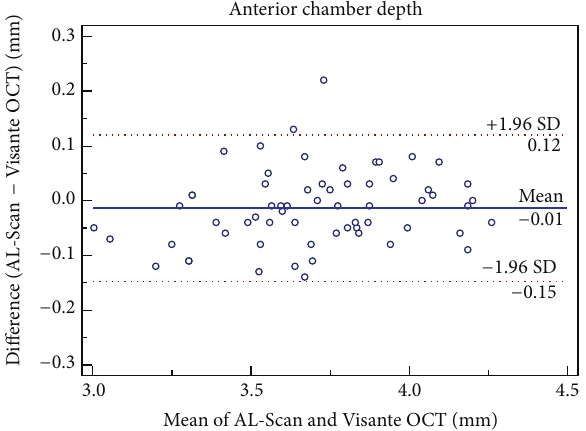
Figure 3: Difference in aqueous depth measurements between AL- Scan optical biometer and Pentacam rotating Scheimpflug imaging device against their mean values. The solid line indicates the mean difference, and 95% limits of agreement are indicated by solid and dotted lines,